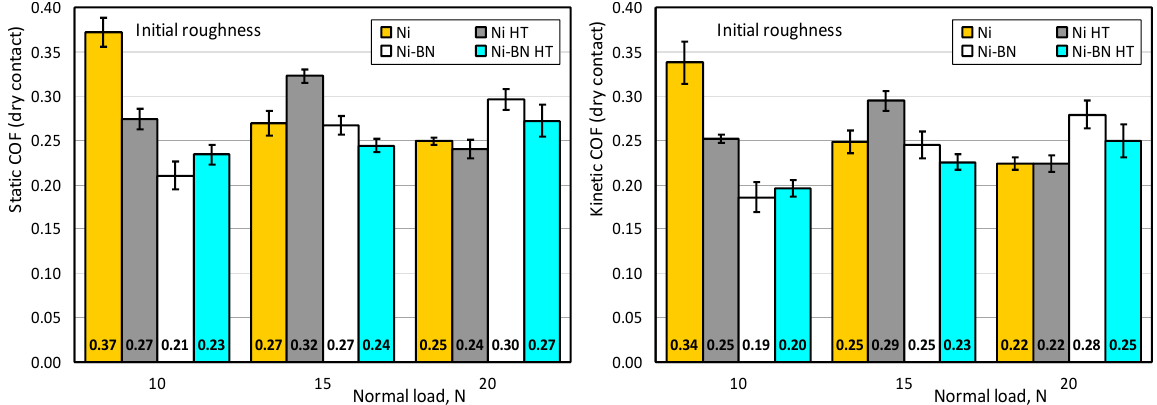
Figure 7. Static and kinetic coefficient of friction (COF) values and appropriate standard deviations of coatings with initial roughness, tested at different normal loads in dry contact conditions.